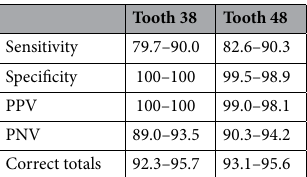
Table 6. Predictive validity (%) of the Cameriere criterion (< 0.08) for predicting age over 18 years in men–